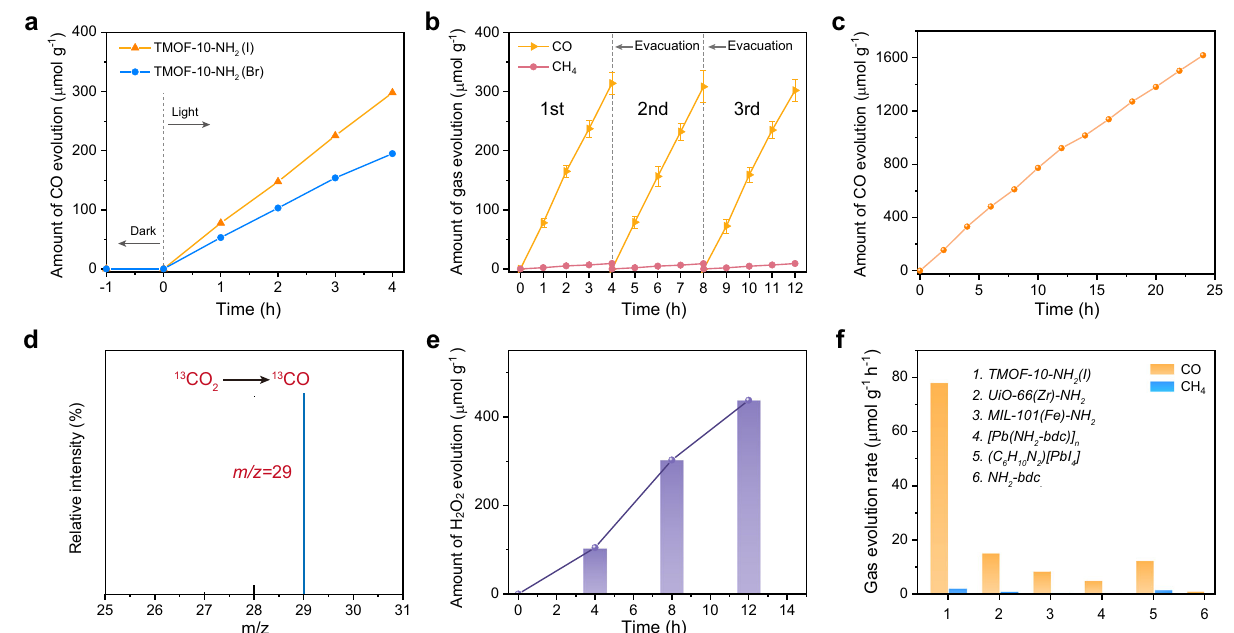
CO 2 of TMOF-10-NH 2 (I). The system was continuous irradiated under AM1.5G simulated sunlight for 24h and gas products were measured every 2hours. d GC- MS results of 13 CO produced over TMOF-10-NH 2 (I) from 13 CO 2 isotope experiment inwatervapor. e AmountofH 2 O 2 producedasafunctionofthetime. f Comparison of gas evolution rates between TMOF-10-NH 2 (I), UiO-66(Zr)-NH 2 48 ,